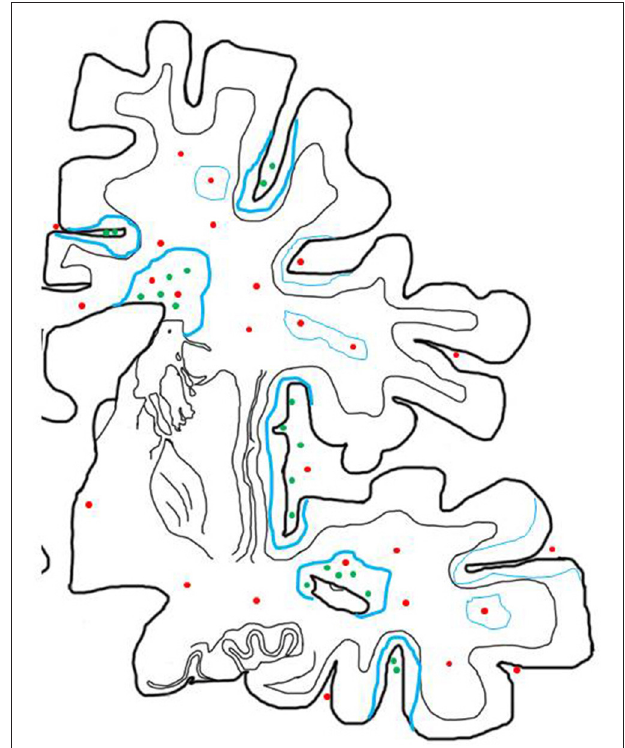
FIGURE 2 | Inflammatory reaction in the brain of patients with progressive MS and its relation to active demyelination and neurodegeneration. The inflammatory reaction in the brain of patients with progressive MS is mainly seen in the large connective tissue spaces of the meninges and the periventricular Virchow Robin spaces. These inflammatory sites mainly contain CD8 + T-cells, a major component of CD20 + B-cells and a variable number of plasma cells and may in their most severe manifestations become organized in structures with features of tertiary lymph follicles (green dots). In addition there are perivascular cuffs mainly composed of CD8 + T-cells, which are more broadly dispersed within the white matter of the brain (red dots). Inflammation with T-cells, B-cells and Plasma cells (green dots) is associated with slow expansion of demyelinated lesions, defined by a rim of activated microglia cells, which in part contain early myelin degradation products in the cortex and the white matter (thick blue lines). Active demyelination and diffuse tissue injury occurs at a distance from the lymphocytic infiltrates and may, thus, be propagated by a soluble demyelinating or neurotoxic factor. Inactive plaques (thin green lines) can still be centered by a vein with a dominant infiltrate by CD8 + T-cells (red